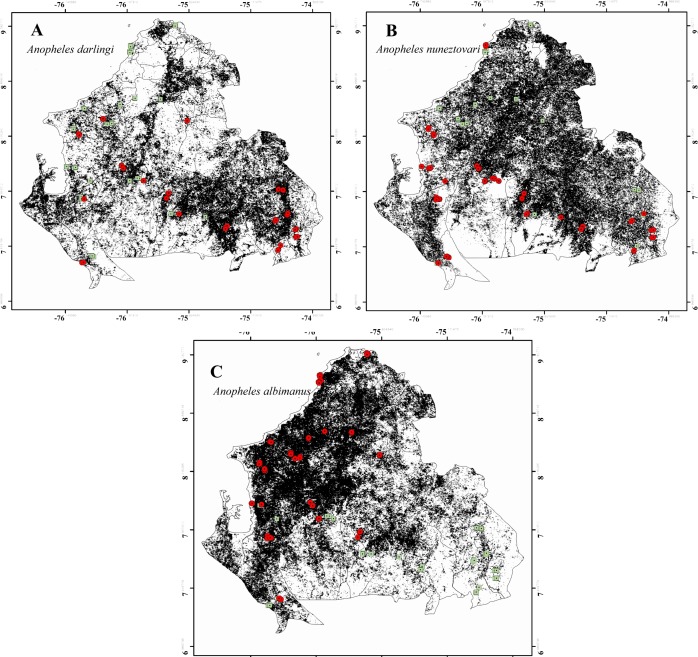
Ecological niche models.Showing environmental suitability for the three Colombian main malaria vectors across the Urabá-Bajo Cauca and Alto Sinú endemic region. Red circles indicate location of the records used for model calibration and green squares indicate absence records.